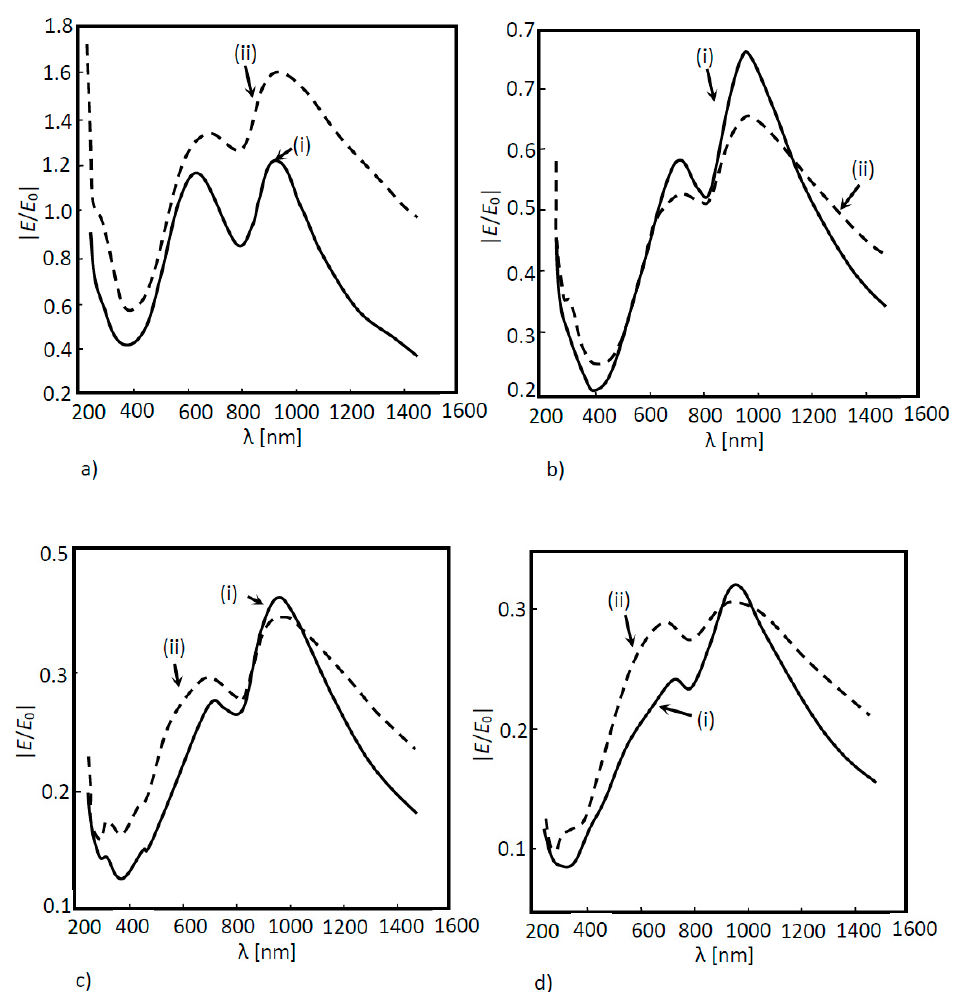
Figure 12. Normalized electric field as a function of the wavelength for a 3D a-Si solar cell structure for two different configurations of nanoantenna hole apertures: (i) conical structures; (ii) cylindrical structures. The normalized electric field was measured between layers as shown in ( a ) probe 1; ( b ) probe 2; ( c ) probe 3 and ( d ) probe 4.